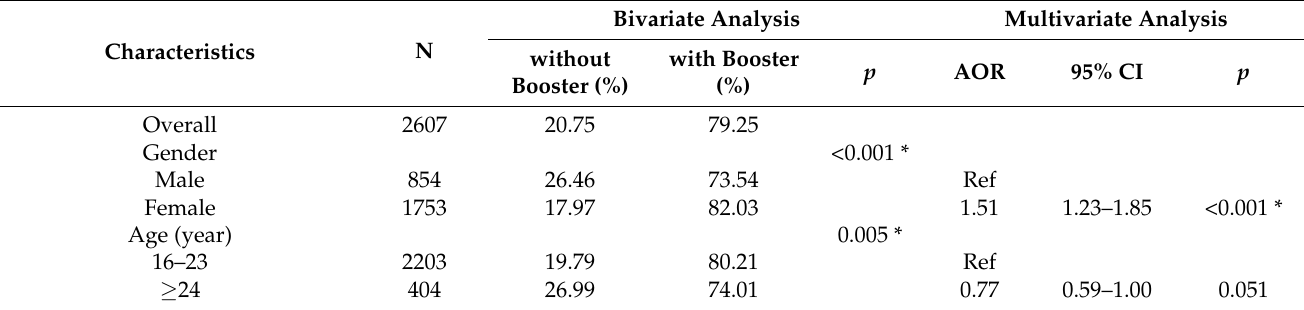
Table 3. Uptake of COVID-19 booster dose among Chinese college students who got full vaccination with the adenovirus vector vaccine or the inactivated vaccine (N =